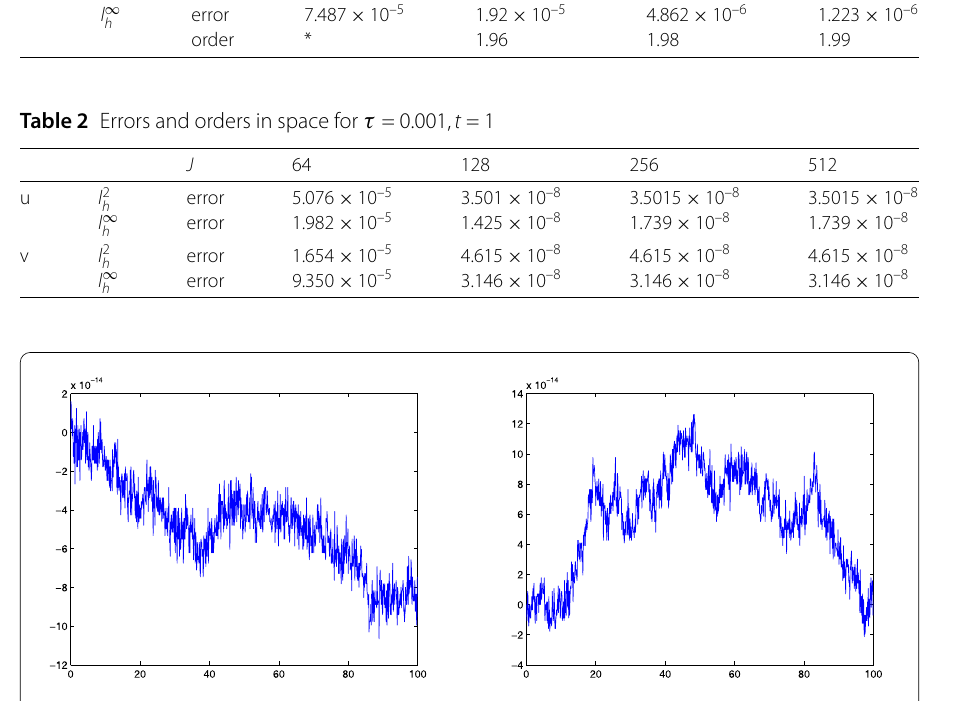
Figure 1 Errors of mass M n (left column) and energy E n (right column) of the numerical